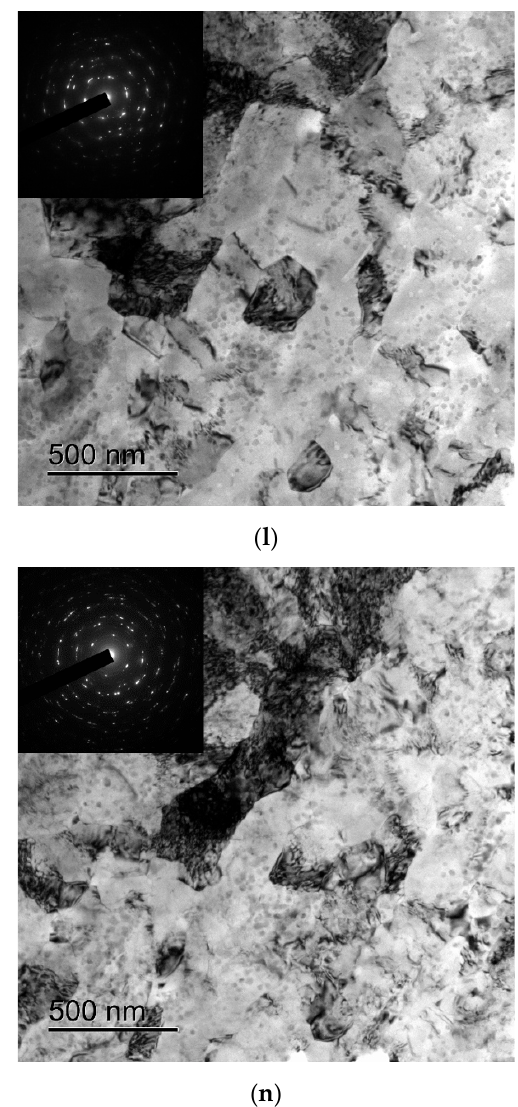
Figure A1. TEM images of the microstructure of UFG steel AISI 321L (ECAP, N = 4 at 450 ° C) at room temperature ( a ) and after in situ heating: ( b ) 300 ° С , 1 h; ( c ) 500 °C, 0 h; ( d ) 500 °C, 0.5 h; ( e ) 500 °C, 1 h; ( f ) 600 °C, 0 h; ( g ) 600 °C, 0.5 h; ( h ) 600 °C, 1 h; ( i ) 700 °C, 0 h; ( j ) 700 °C, 0.5 h; ( k ) 700 °C, 1 h; ( l ) 800 °C, 0 h; ( m ) 800 °C, 0.5 h; ( n ) 800 °C, 1 h.